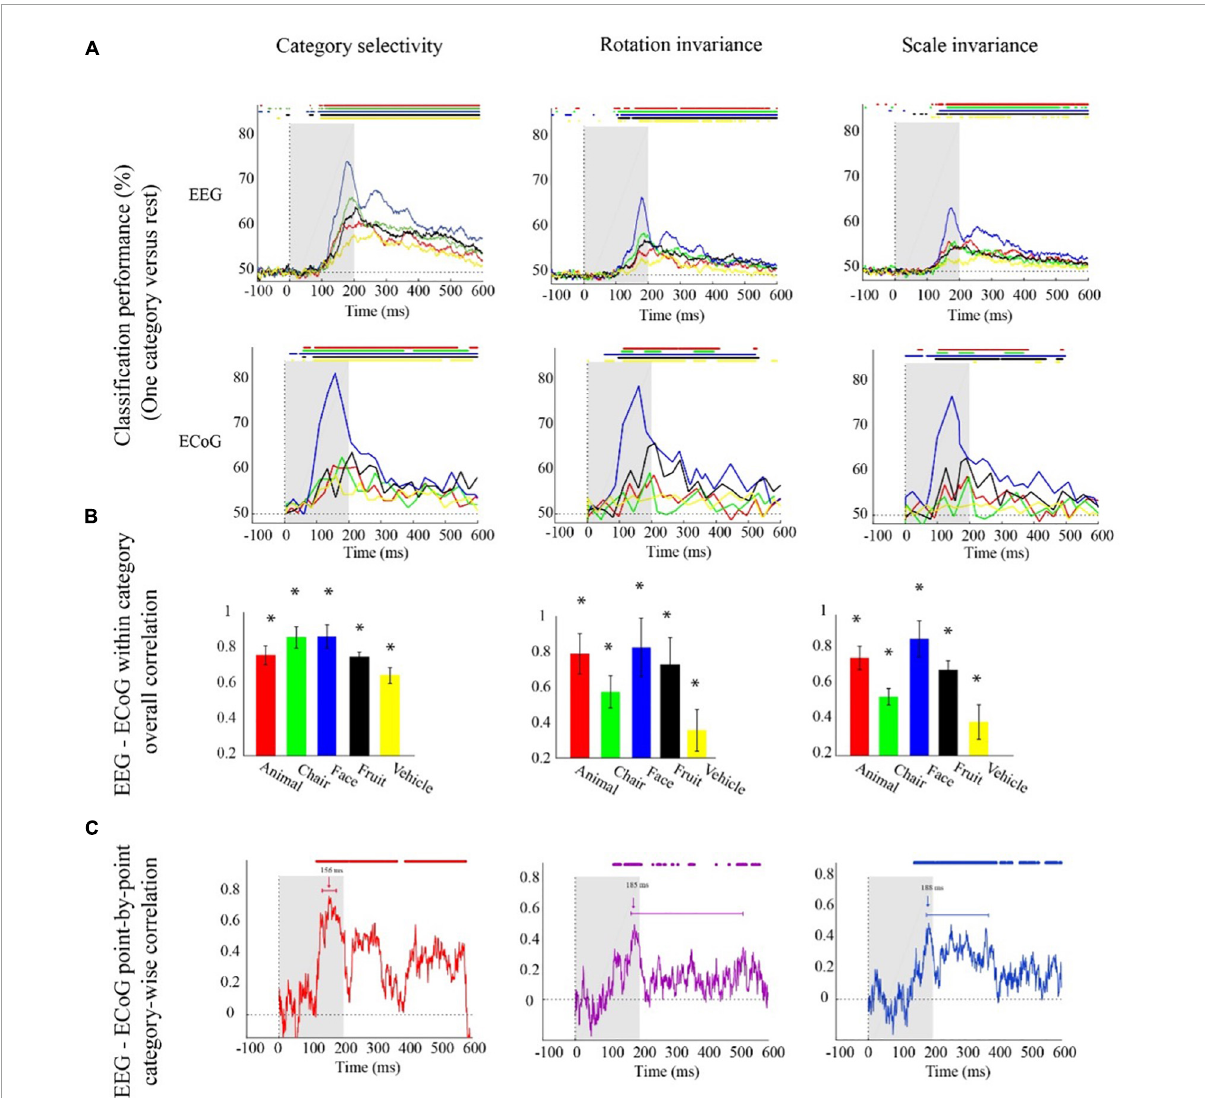
FIGURE2 Electroencephalogram and ECoG category-specific classification performances over time. (A) Classification performances across all channels of EEG averaged over 21 participants, and ECoG classification performances using 11 selective electrodes and IFP (intracranial field potential) power in bins of 25 ms. The horizontal lines above the curves indicate significant time points (EEG: bootstrap test of 21 participants with 10,000 repetitions, FDR-corrected at p < 0.05, ECoG: permutation test over stimuli, not corrected). (B) EEG–ECoG category-wise overall correlation. Bar charts show the correlation coefficients between the classification time courses performances of EEG and ECoG for each category separately for the two modalities. The bars are color-coded, and the stars indicate significance (bootstrap test of 21 participants with 10,000 repetitions). (C) EEG–ECoG time-resolved point-by-point category-wise correlation. For each time point, we compared classification performance across categories between EEG and ECoG. At each time point, accuracies for categories were compared between EEG and ECoG. The horizontal lines above the curves indicate significant time points (bootstrap test of 21 participants with 10,000 repetitions, FDR-corrected at p < 0.05). For ECoG, the results are presented as reported in Liu et al. (2009). We did not analyze the data; we reproduced the figures in Liu et al.